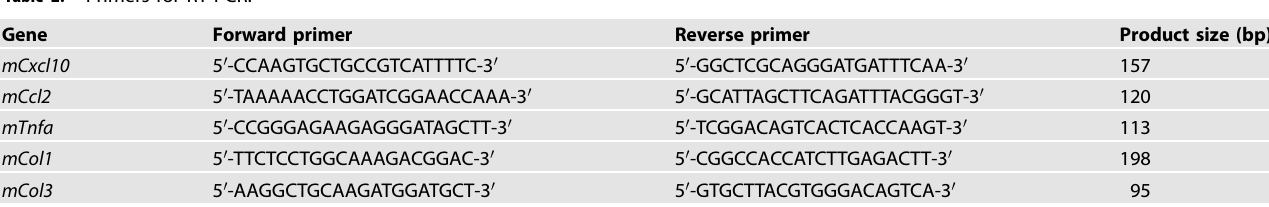
Table 2. Primers for